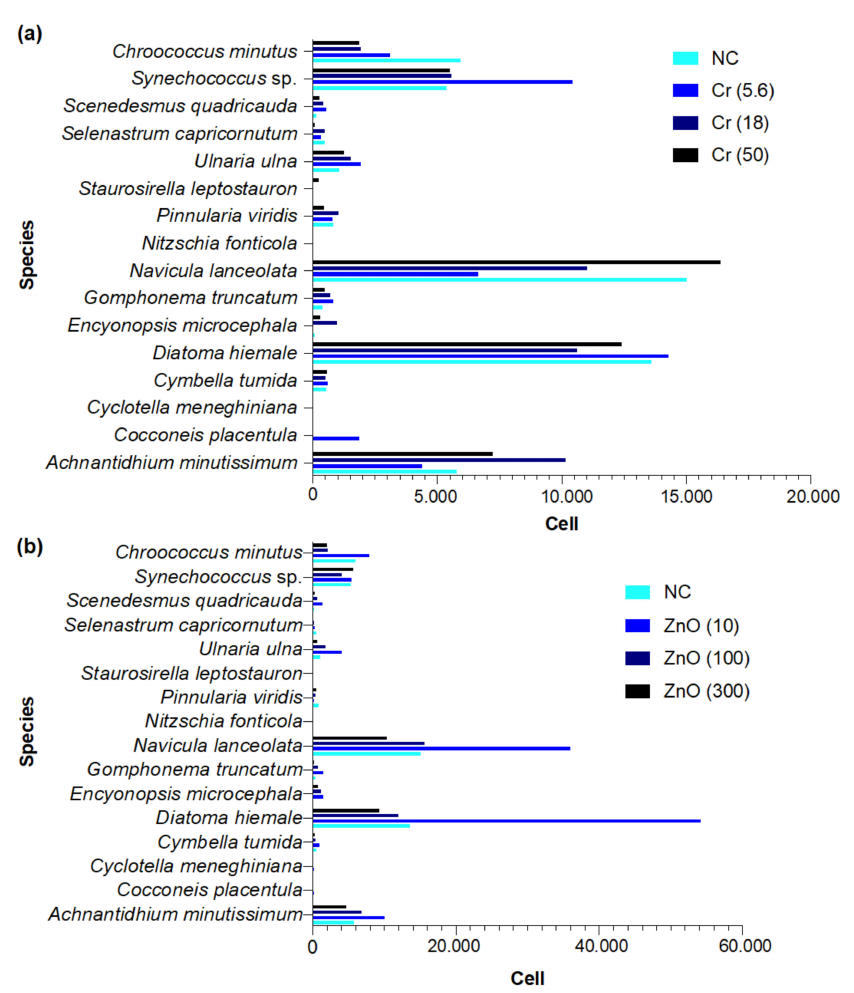
Figure 5. Mean number of cells recorded at each concentration of Cr 2 O 7 (Cr; ( a )) and ZnO (Zn; ( b )), negative control (NC) included in freshwater phytoplankton community.